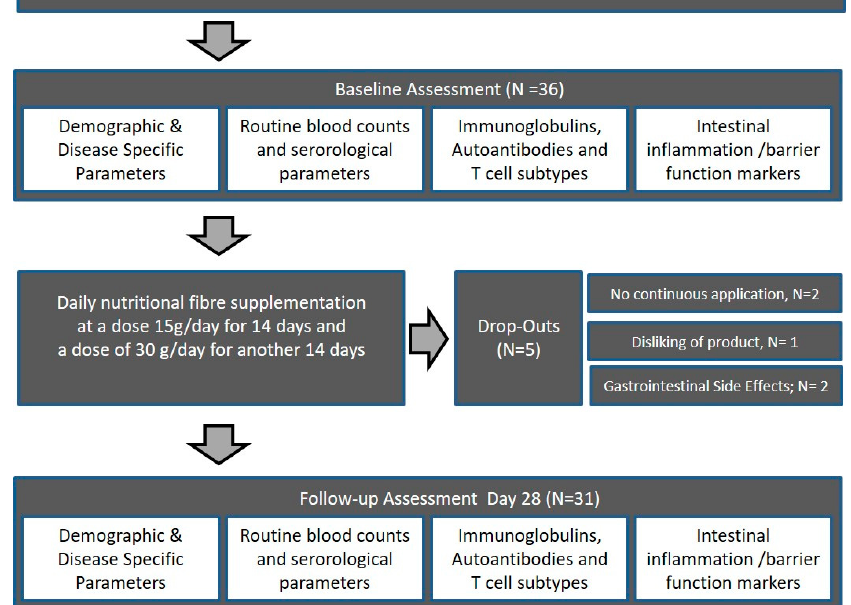
Figure 1. Subject flow chart of the high-fiber dietary supplementation feasibility study. RA, rheumatoid arthritis; DMARDs, disease-modifying anti-rheumatic drugs. ACR/EULAR, American College of Rheumatology/European League Against Rheumatism.